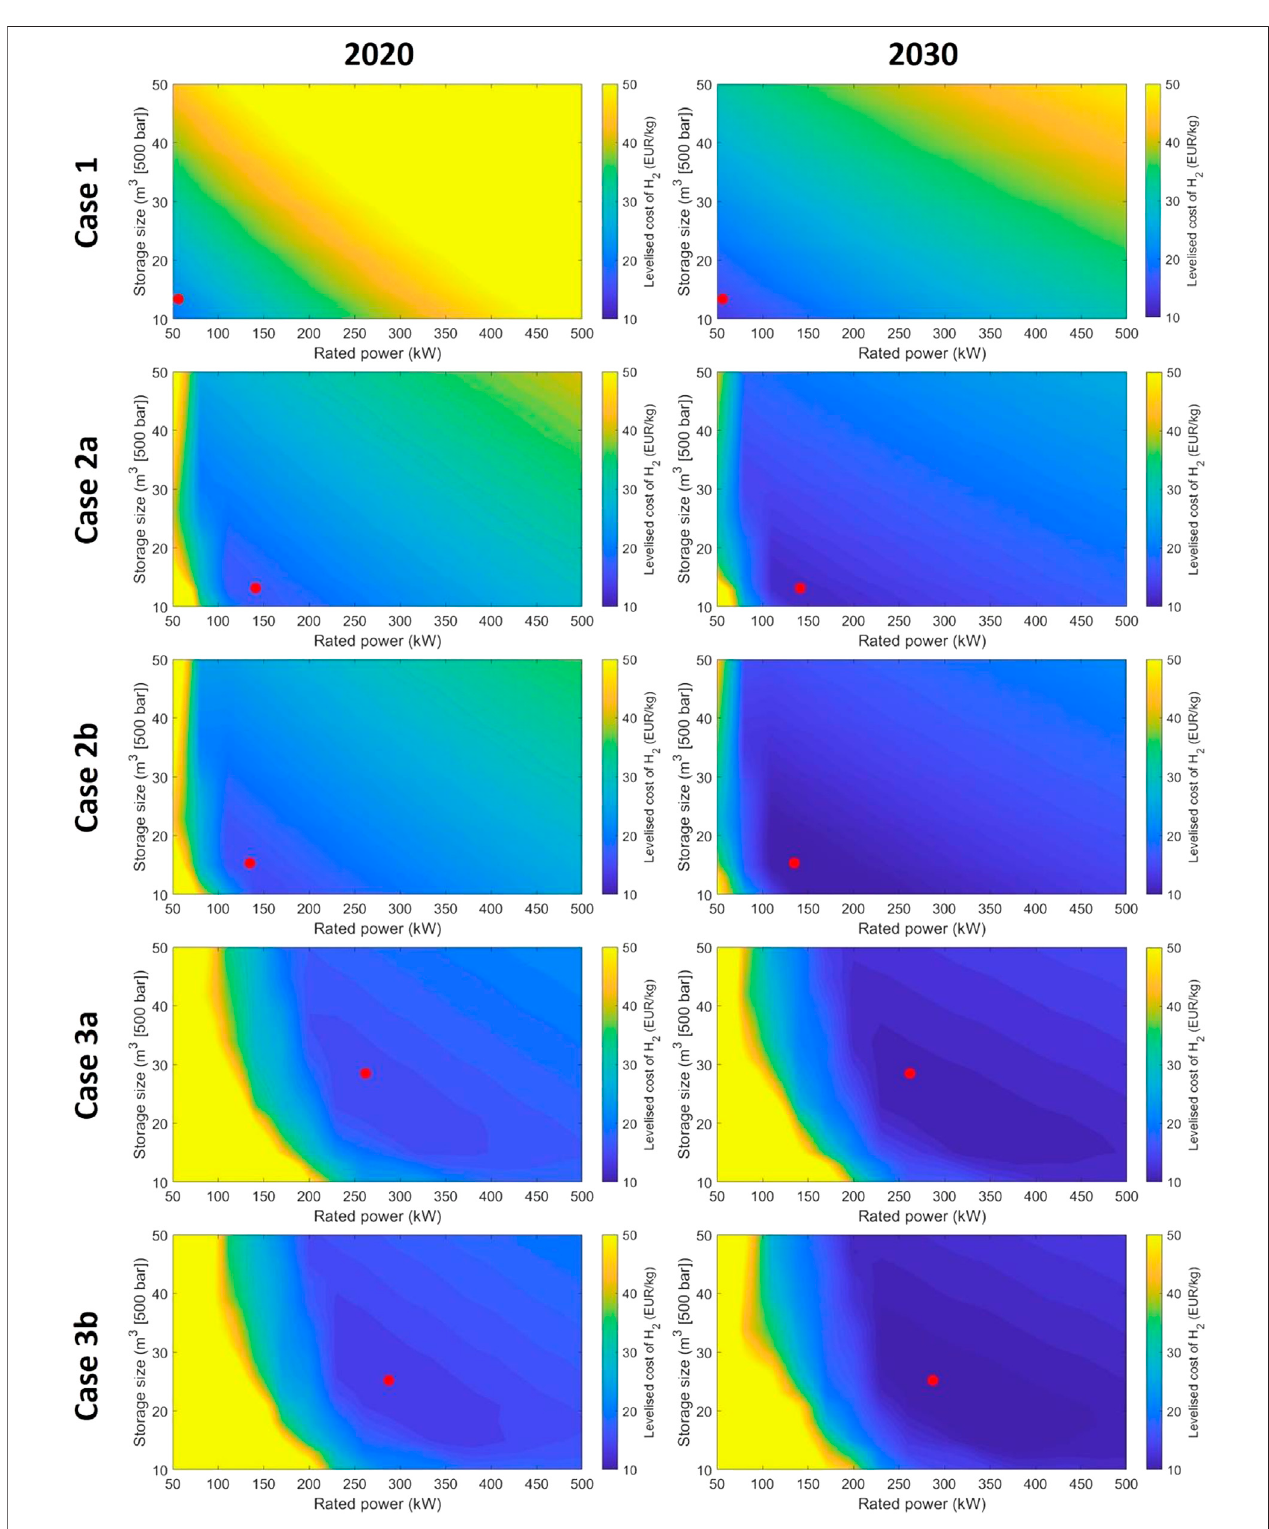
FIGURE A2 | Optimization of PtH 2 plant con fi guration (LCOH 2 ). Note: Red dot shows the optimal plant con fi guration to minimize LCOH 2 .